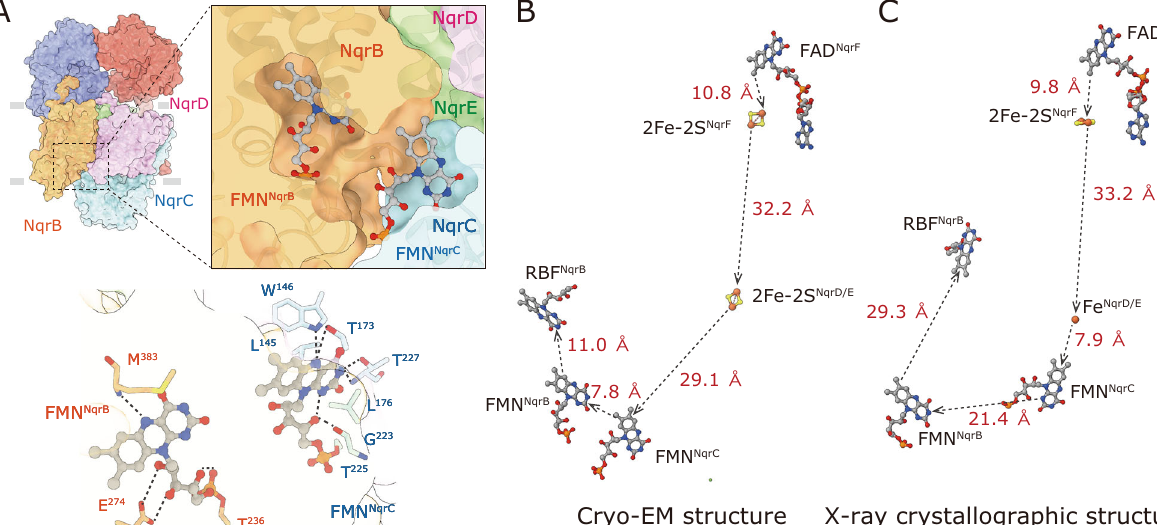
Fig. 5 Positions of all cofactors in Na + -NQR. A The structure around FMN in NqrC. The head-group of FMN protrudes from the NqrC protein matrix and lies in the periplasmic medium cavity formed by NqrB, NqrD, and NqrE ( an upper panel ). FMN NqrC and FMN NqrB face each other in the closed pocket at the periplasmic interface between NqrB and NqrC. The residues that interact with FMN NqrC and FMN NqrB are indicated (a lower panel ). The possible hydrogen bonds are represented as dashed lines . The positions of all cofactors in the present cryo-EM structure ( B ) and the X-ray crystallographic structure ( C ) 16 are illustrated. The edge-to-edge distances of the cofactors are